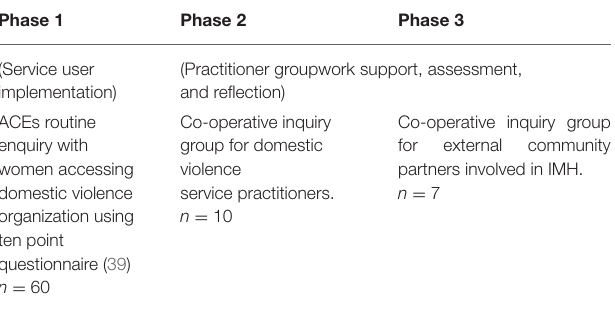
TABLE 1 | Study design. Phase